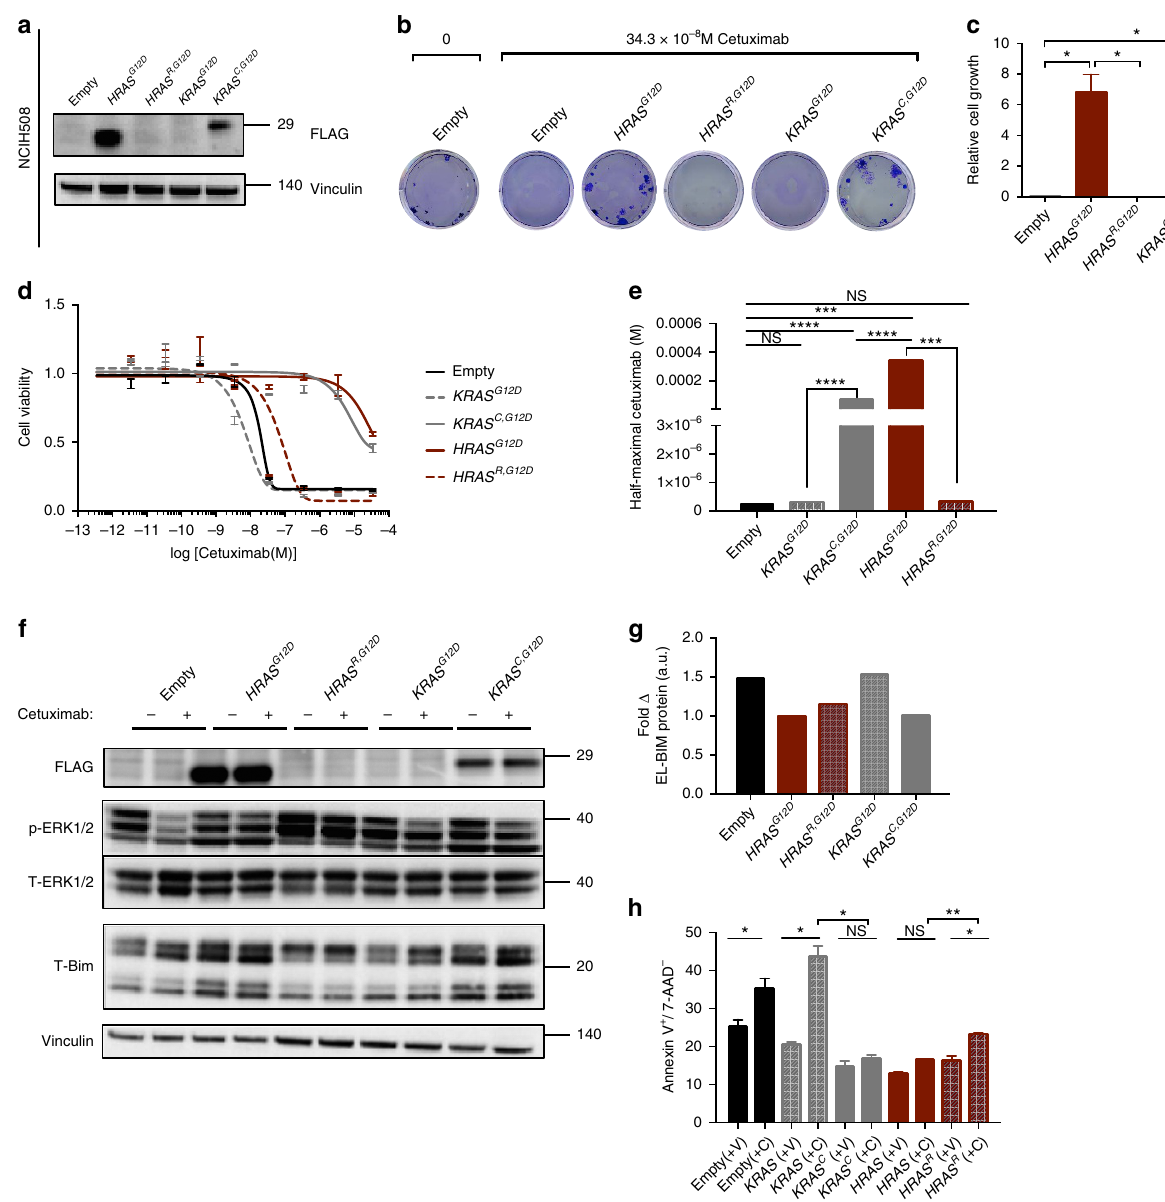
Figure 3 | Rare codons limit KRAS -mediated resistance to cetuximab in colorectal cancer. ( a ) Immunoblot analysis with anti-FLAG or anti-vinculin antibody in NCIH508 cells stably transduced with a vector encoding the indicated transgene (or no transgene, empty). All HRAS and KRAS constructs are FLAG tagged. ( b ) Representative plate of three technical replicates of colony growth assay of various HRAS and KRAS expressing derivatives in the presence of cetuximab or vehicle control. ( c ) Number of colonies in b normalized to cells expressing no transgene, determined when the indicated cell line transduced with vectors encoding the indicated transgenes were treated with cetuximab. ( d ) Nonlinear regression growth curves depicting cell viability as detected by Cell Titer Glo of cells transduced with indicated constructs and treated with an eight-log dilution series of cetuximab. ( e ) Derived half-maximal growth inhibition values of curves in d . ( f ) Immunoblotting of indicated constructs for signalling of phospho- and total-ERK1/2 and T-BIM. All HRAS and KRAS constructs are FLAG tagged as in a , and vinculin is a loading control. ( g ) Fold change in extra long-BIM (EL-BIM) protein levels from the immunoblots in f comparing cetuximab and vehicle treated cells. ( h ) Apoptosis quantification (Annexin V þ /7-AAD (cid:2) ) of indicated constructs in the presence or absence of cetuximab. In all cases, data are average ± s.e.m. ( n ¼ 3 technical replicates per condition). Immunoblotting images are cropped for clarity. * P r 0.05; ** P r 0.01; *** P r 0.001, **** P r 0.0001. P values were calculated with unpaired, two-tailed Student’s t -tests.